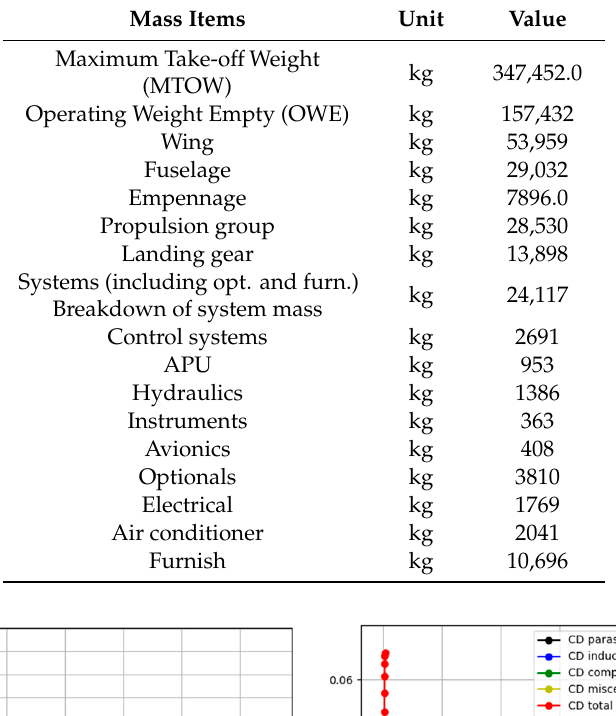
Table A1. Weight break-down of B777 calculated using SUAVE.